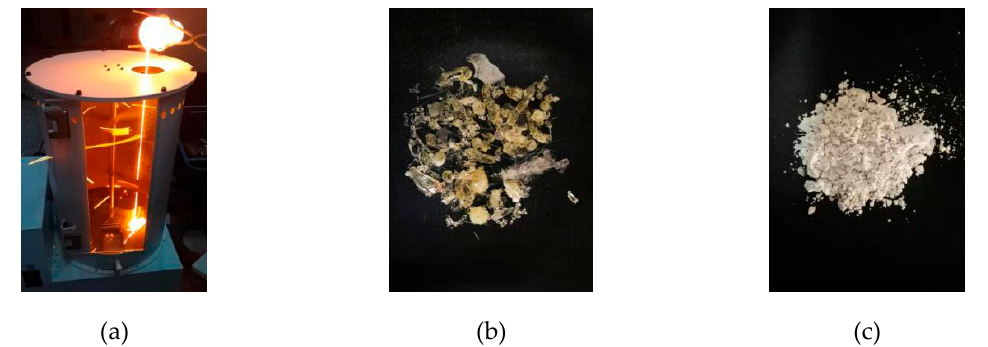
Figure 1. Design of the fan blade granulating device: ( a ) the realistic snap of quenching granulation; 132 ( b ) the final slag product; ( c ) slag powder with specific surface area of 450 m 2 /kg. 133